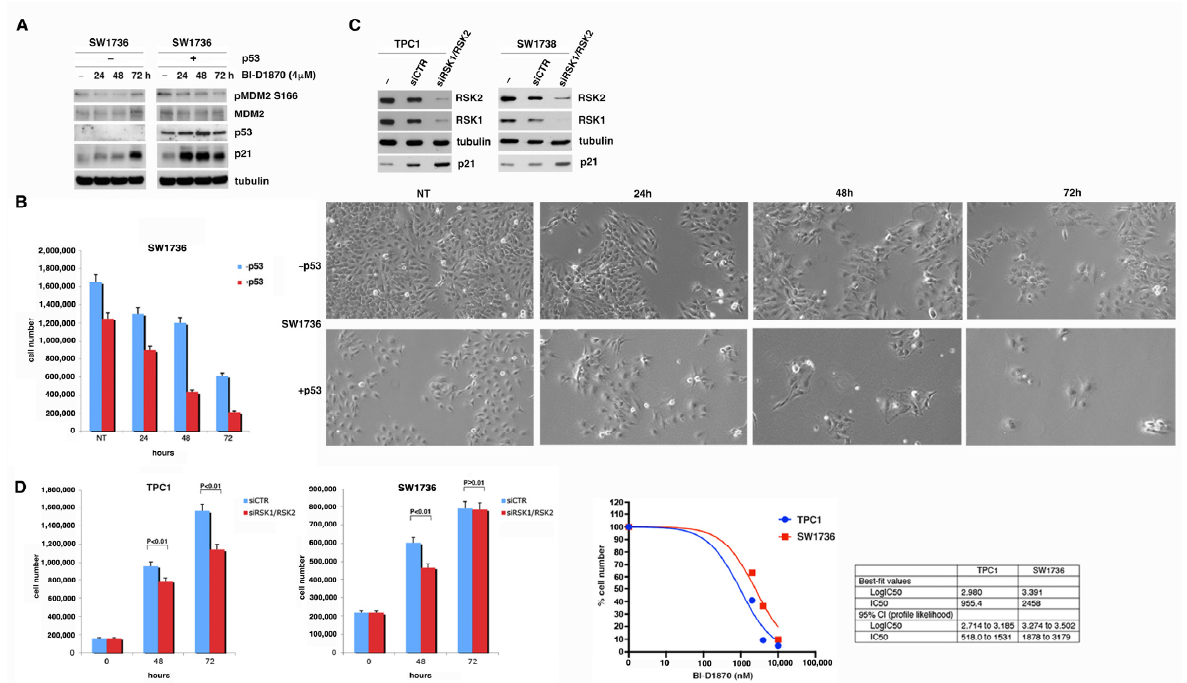
Figure 6. p53 contributes to control of p90RSK-dependent proliferation by regulating p21 expression. ( A ) SW1736 cells were transfected with p53 expression vector (+) or with the empty vector ( − ) and after 24 h treated or not ( − ) with 4 µM BI-D1870 for the indicated times (h). The efficiency of the transfection was verified with anti-p53 antibody. The effectiveness of the treatment was verified with anti-phospho-S166 MDM2 antibody. The immunoblot was then tested with anti-p21 and anti- MDM2 antibodies and normalization was performed by immunoblotting with anti-tubulin anti- body. ( B ) SW1736 cells were transfected (+p53) or not ( − p53) with p53 expression plasmid, treated or not (NT) with 4 µM BI-D1870 for the indicated times (hours) and counted. The experiment was conducted in triplicate. The histogram indicates the mean of the results for non-treated (NT), 24, 48, and 72 h and the calculated standard deviation was indicated (left panel). SW1736 (+/ − p53) were then photographed in the optical field at 10× magnification. Representative fields were shown (right panel); ( C ) TPC1 (left panel) and SW1736 (right panel) cells were transfected with RNA interference against RSK1 and RSK2 (pool of specific RSK1/RSK2 siRNAs) or with control RNA interference (siCTR). The interference efficiency was verified with anti-RSK1 and anti-RSK2 antibodies. p21 total level was revealed with anti-p21 antibody. Normalization was performed by immunoblotting with anti-tubulin antibody. ( D ) Growth curve of TPC1 and SW1736 cells transfected with RNA interfer- ence against RSK1 and RSK2 (siRSK1/RSK2) or with control RNA interference (siCTR). The experi- ment was conducted in triplicate. The histogram indicates the mean of the results at 0, 48 h, and 72 h and the calculated standard deviation was indicated (left panels). Dose–response curve at 72 h of TPC1 and SW1736 cells treated or not with 2, 4, 10 µM BI-D1870 (right panel). BI-D1870 IC50 and 95% confidence interval (95% CI) calculated for TPC1 and SW1736 at 72 h of treatment were shown in the insert table.